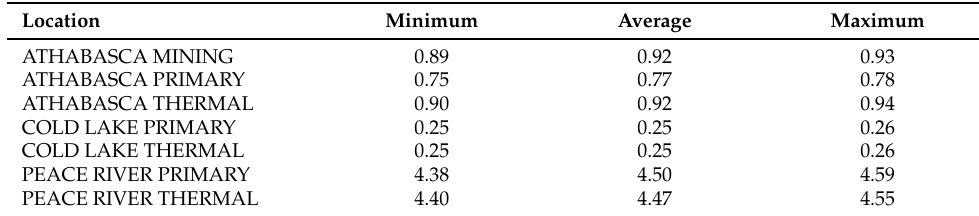
Table A2. Assumed transportation adjustments summary table (CAD per barrel of bitumen). Location Minimum Average Maximum ATHABASCA